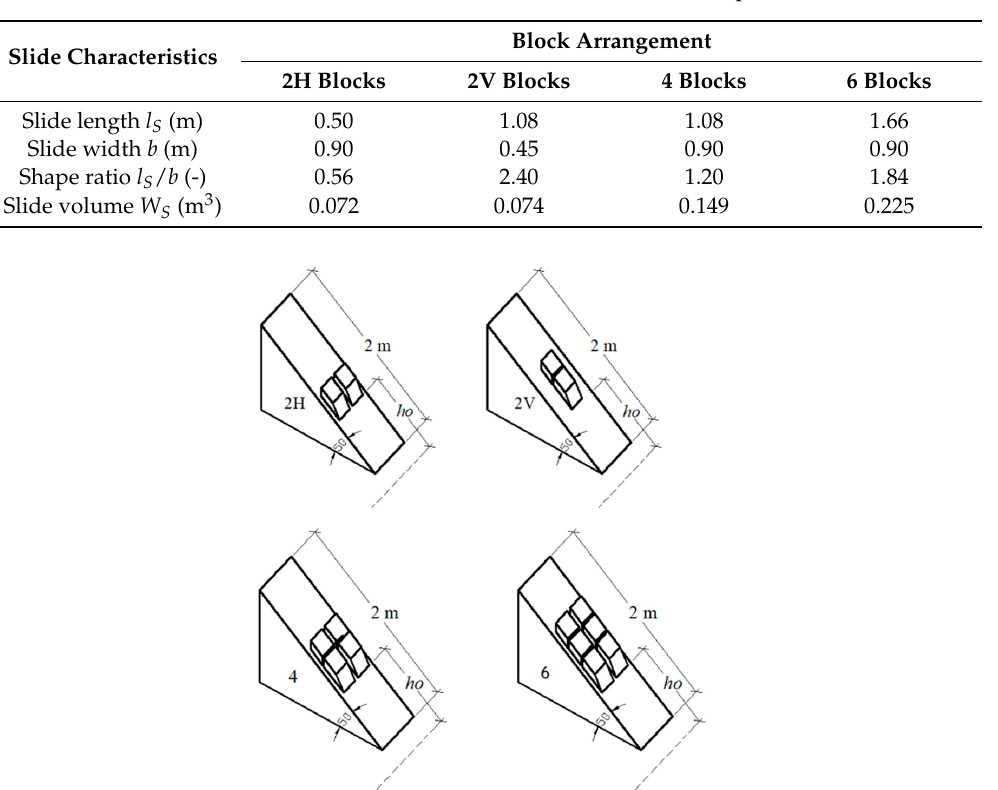
Table 2. Slide block characteristics in the model set-up.